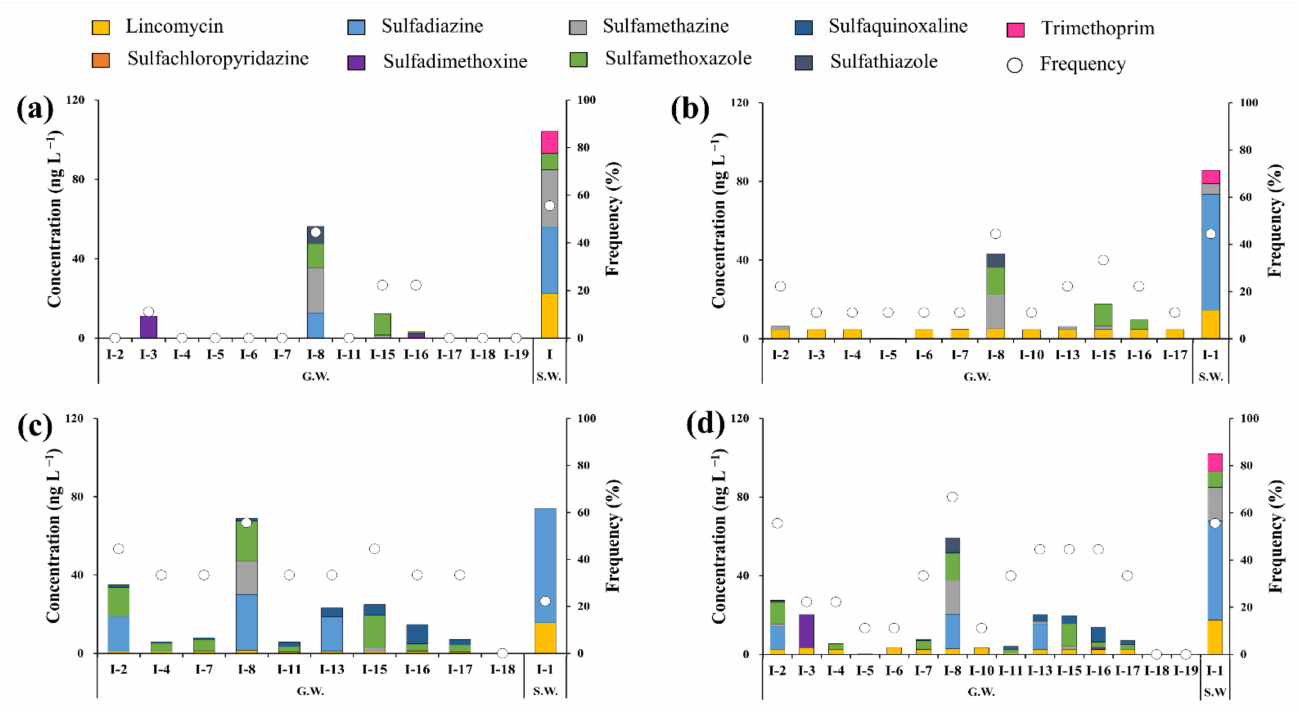
Figure 6. Residual cumulative concentrations of antibiotics in samples collected at each sampling point in ( a ) March, ( b ) June, ( c ) August, ( d ) Average concentrations of samples collected from March to August; Yellow: lincomycin, Orange: Sulfachloropyridazine, Sky blue: Sulfadiazine, Purple: Sulfadimethoxine, Grey: Sulfamethazine, Green: Sulfamethoxazole, Dark blue: Sulfaquinoxaline, Black: Sulfathiazole, Pink: Trimethoprim, Circle: